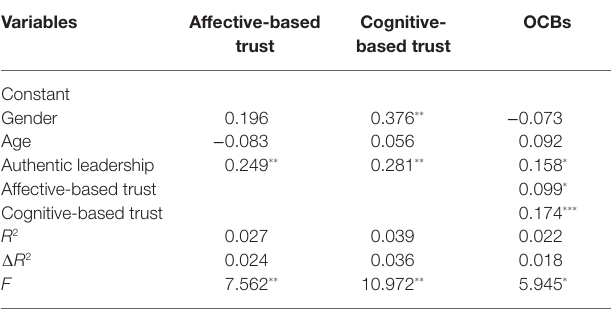
TABLE 2 | Regression analysis of authentic leadership, affective-based trust, cognitive-based trust, and OCBs.